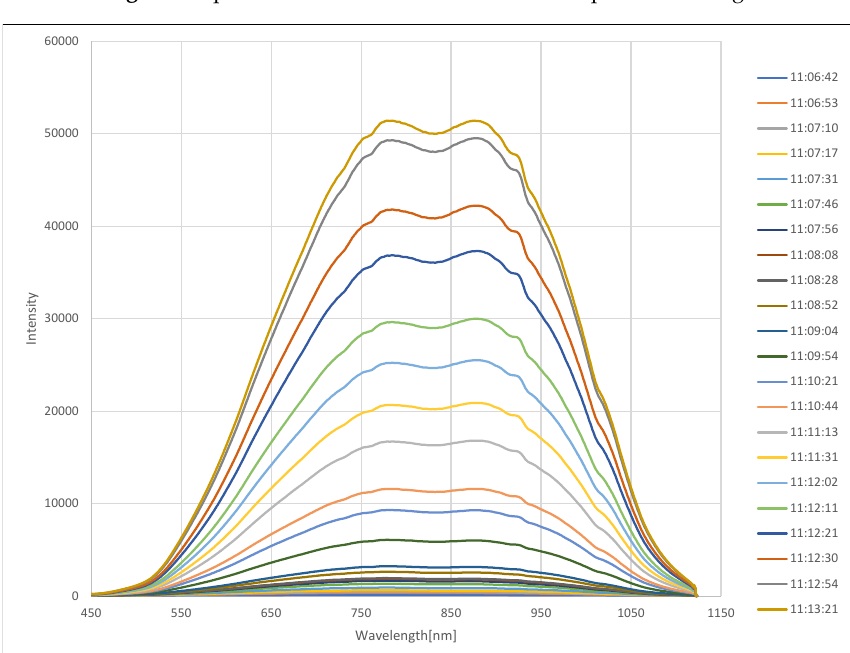
Figure 8. Intensity change of light from a halogen lamp according to the concentration of